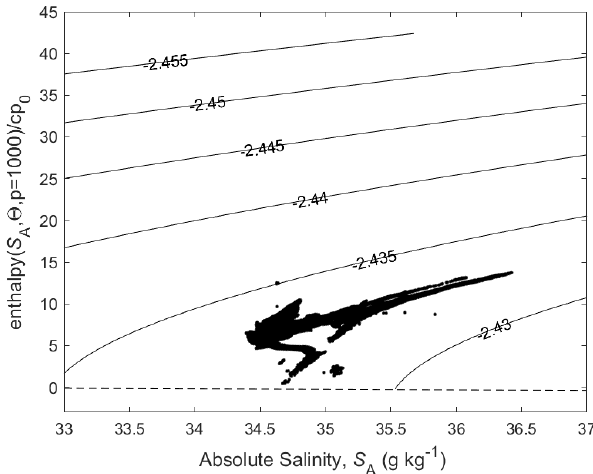
Figure 3. Contours of (cid:50) − ˆ h(S A ,(cid:50), 1000dbar )/c 0 p on the Absolute Salinity – ˆ h(S A ,(cid:50), 1000dbar )c 0 p diagram. Enthalpy, ˆ h(S A ,(cid:50), 1000dbar ) , is a conservative quantity for turbulent mix- ing processes that occur at a pressure of 1000dbar. The mean value of the contoured quantity is approximately − 2 . 44 ◦ C, illustrating that enthalpy does not possess the “potential” property; that is, en- thalpy increases during adiabatic and isohaline increases in pres- sure. The fact that the contoured quantity in this figure is not a lin- ear function of S A and ˆ h(S A ,(cid:50), 1000dbar ) illustrates the (small) non-conservative nature of Conservative Temperature. The dots are data from the world ocean at